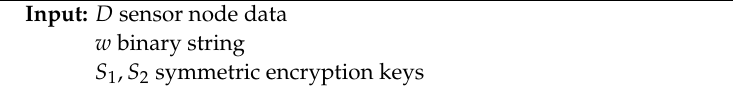
Algorithm 1: Data filtering to supervise social distancing violations